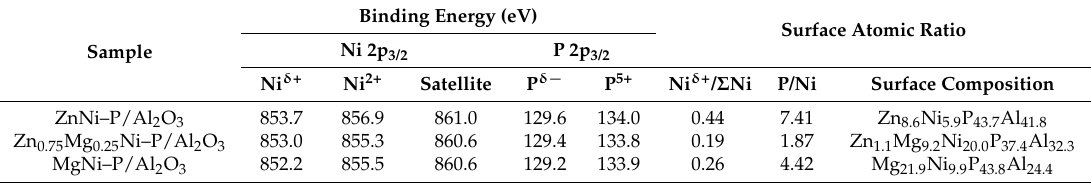
Figure 4. XPS spectra of ZnNi–P/Al 2 O 3 , Zn 0.75 Mg 0.25 Ni–P/Al 2 O 3 , and MgNi–P/Al 2 O 3 : ( a ) Ni 2p; ( b ) P 2p. Table 3. Spectral parameters obtained by X-ray photoelectron spectroscopy (XPS)